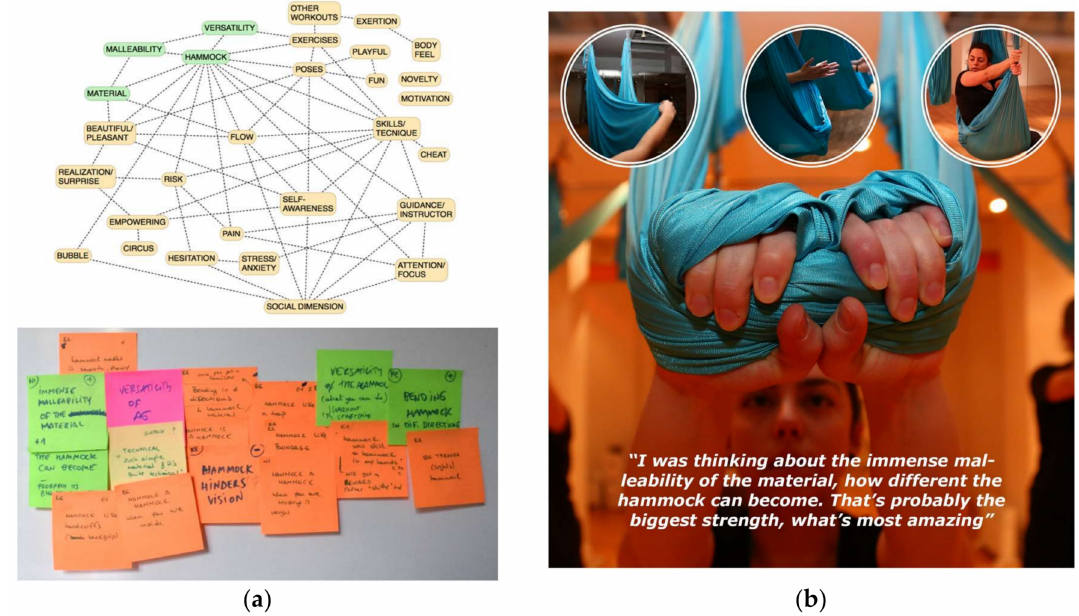
Figure 13. Versatility of the Hammock . ( a ) The corresponding analysis’ categories, with the four that the SomaBoard relate to ( malleability, material, hammock and versatility ) highlighted, and a picture of the original post-its. ( b ) SomaBoard depicting the malleability of the fabric of the hammock through several images representing moments where the hammock was used in dramatically different ways precisely thanks to the malleability of its